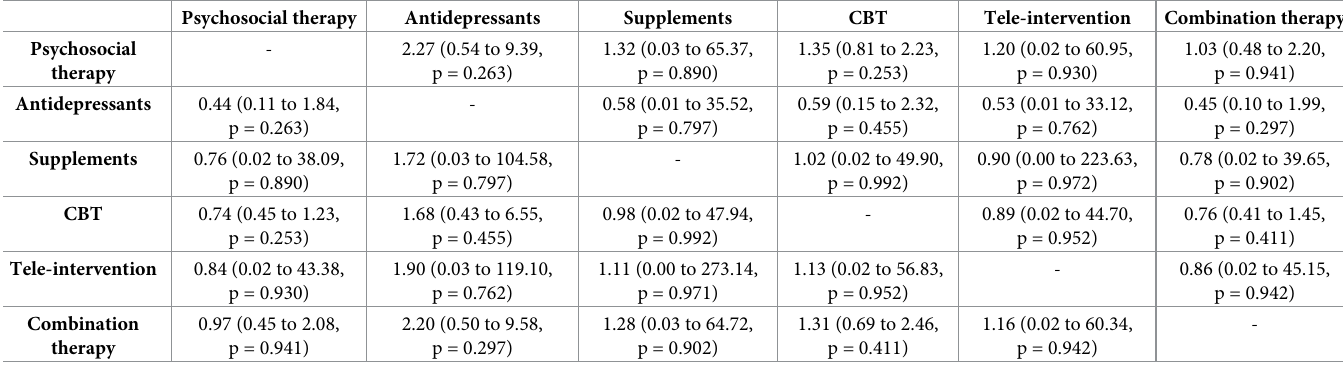
Table 3. Summary of network analysis for overall mortality.